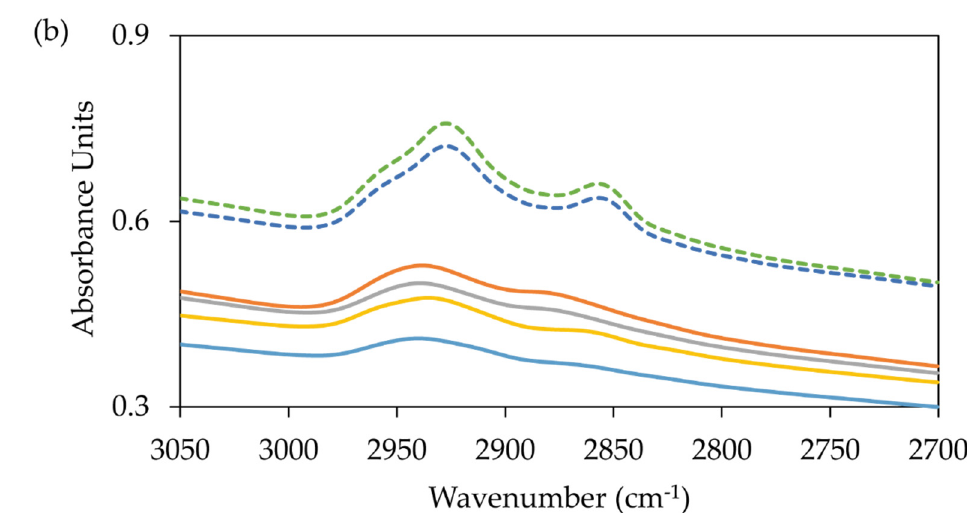
Figure 4. MIR spectrum of six di ff erent membrane protein purifications in octyl glucose neopentyl glycol (OGNG) with cholesteryl hemisuccinate (CHS) from ZMPSTE24 (solid lines) and a membrane receptor (dashed lines). ( a ) Full MIR spectra and ( b ) magnified MIR spectra (3050–2700 cm − 1 ). Using a standard curve for a given detergent the amount of detergent in a sample can be quantified. In four of these cases (blue, yellow, grey and orange) detergent content is low (between 0.25% and 0.5%) and at the detection limit for the method. Low detergent readings are expected for these optimised purifications where detergent content is minimised throughout the purification. In the case of the membrane receptor, detergent concentrations are much higher ~2% (dark blue and green) as indicated by the peak at 2850 cm − 1 .